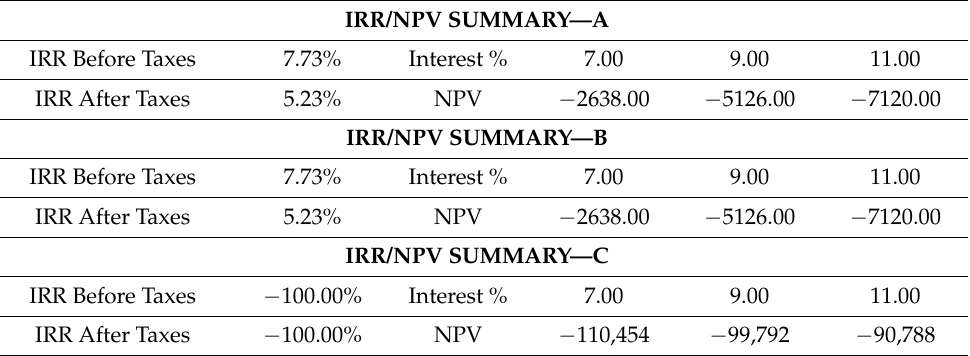
Table 9. The IRR and tax summary of the three factories—kitchen waste (A), spent grain (B), and control